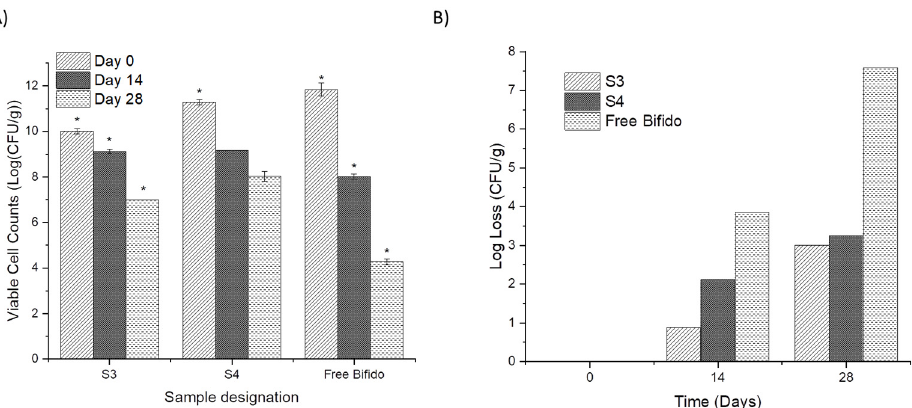
Figure 7. Viable cell counts ( A ) and log loss of viability ( B ) over time (30 °C and 40% RH) of encapsulated Bifido within electrosprayed ETC core-shell microcapsules, and non-encapsulated (free) cells. All values are mean ± standard deviation, and * indicates significant difference ( p < 0.05).